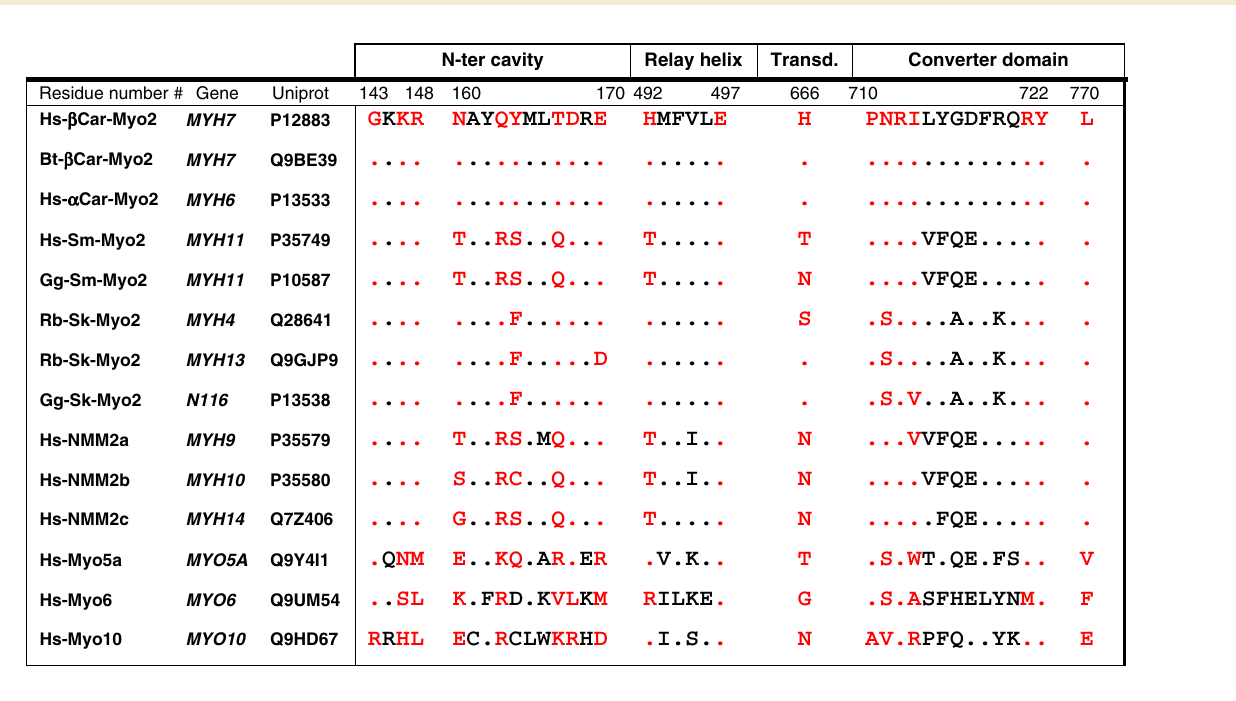
Table 3 Sequence variability for myosin residues found in the OM PPS binding pocket